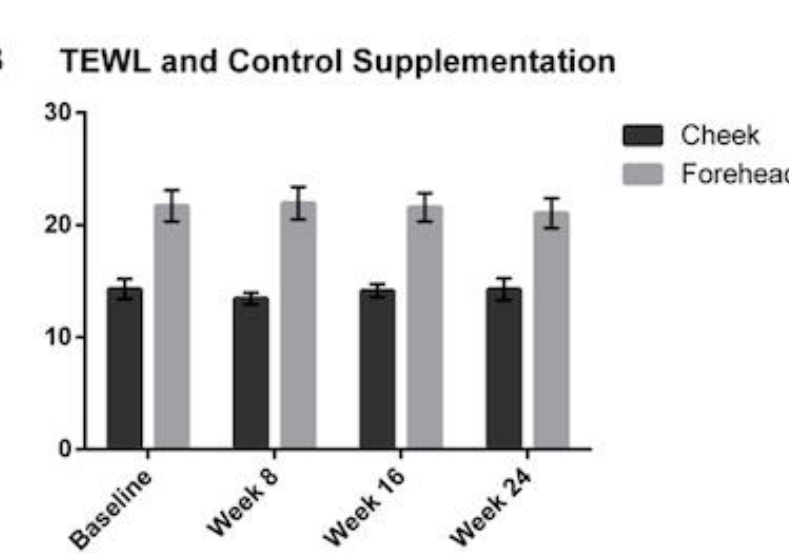
Figure 6. Changes in transepidermal water loss were measured at baseline, 8, 16 and 24 weeks, showing no significant differences detected between the ( A ) almond and ( B ) control groups. Error bars represent SEM.